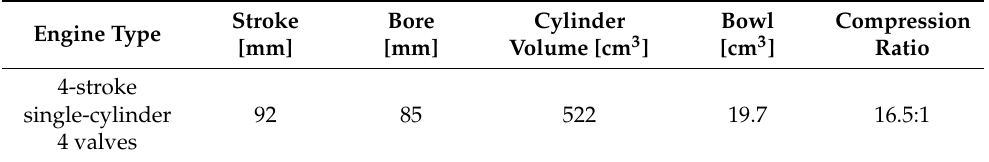
Table 1. Engine specifications.